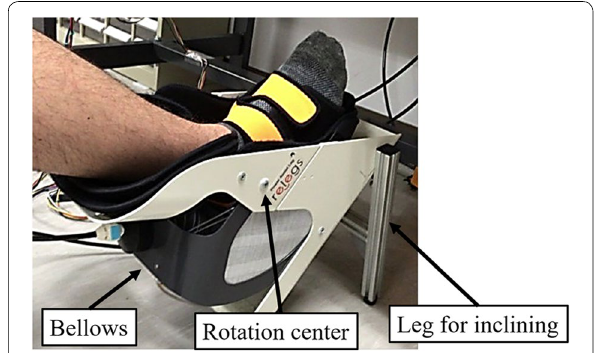
Fig. 2 Prototype of stretching machine for ankle dorsiflexion. The foot is dorsiflexed slowly and maintained in dorsiflexed posture (Adapted from